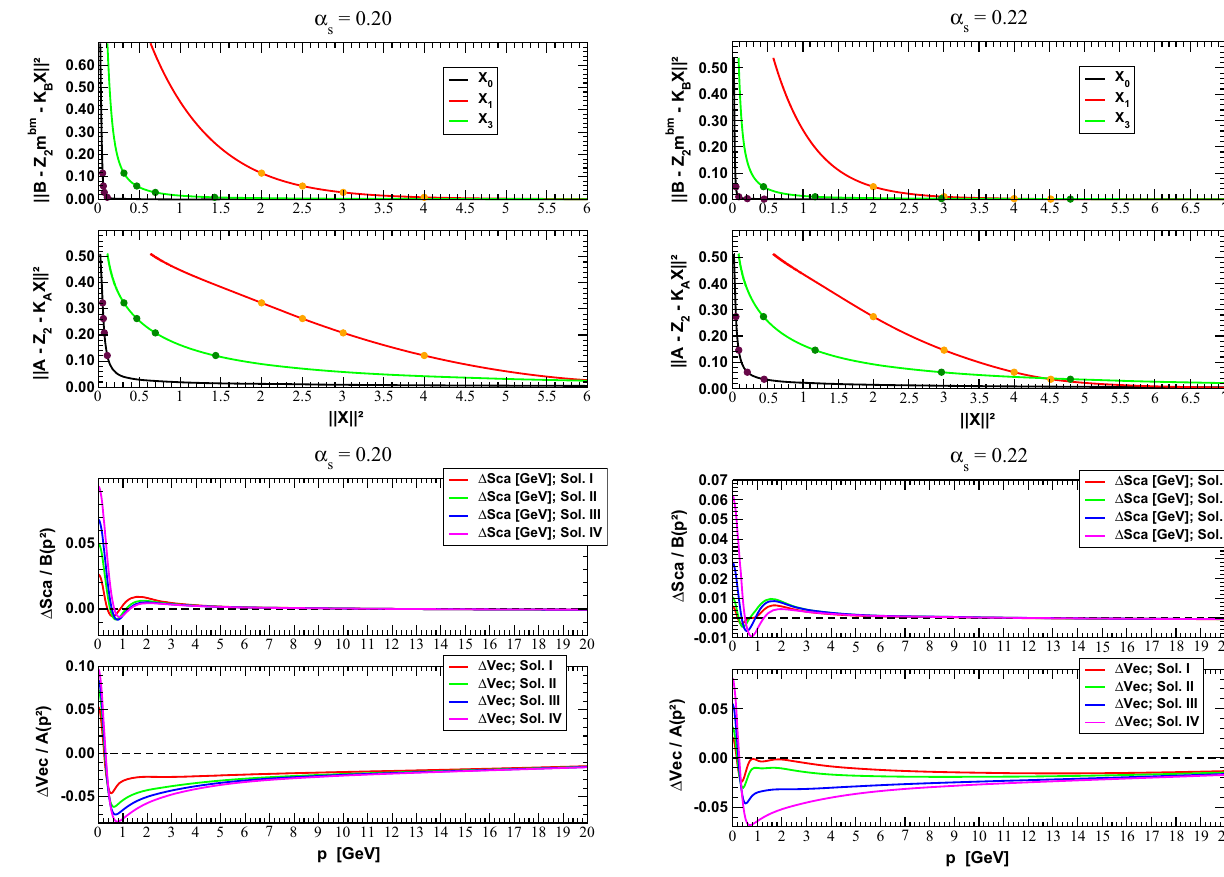
Fig. 31 NormversusResiduum(top)andrelativeerrorofthesolutions of the gap equation for α s (μ) = 0 . 22. The solutions on the right plot are those marked on the left plot with I being that associated to the most right mark 7 The Quark-Gluon vertex form factors In the previous section we have computed the quark-ghost kernel form factors X 0 ( q 2 ) , Y 1 ( q 2 ) , Y 3 ( q 2 ) that, together with the quark, gluon and ghost propagators, define the full form factors as given in Eqs. (59), (60) and (61). Once the full quark-ghost kernel form factors are known, then the lon- gitudinal quark-gluon form factors can be computed using Eqs. (26)–(29), after performing the rotation to the Euclidean , p 2 ) functions to space and identifying the g i ( p 2 1 2 , p 2 ) = 1 g 0 ( p 2 1 2